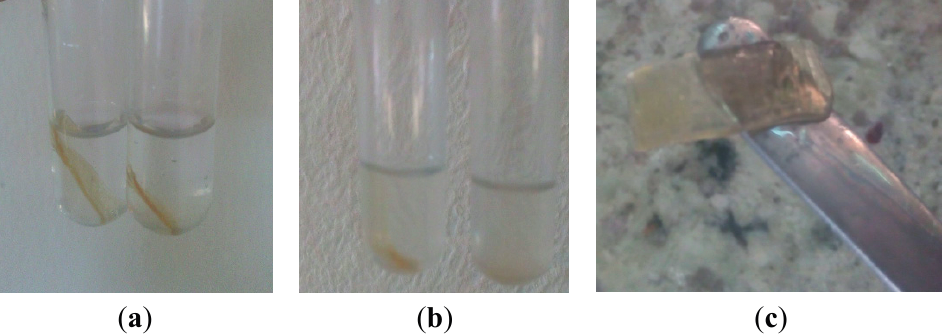
Figure 6. Moisture absorption of Fish scale biopolymer with 20 g NC/5 g FSBP and 30 g NC/5 g FSBP nanocellulose gel.